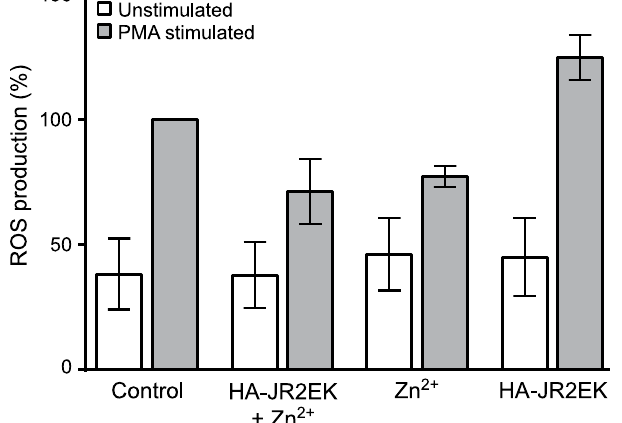
Figure 5. ROS modulatory effects of hydrogels. DCF-DA loaded isolated human neutrophil granulocytes were treated with ± HA-JR2EK (2.5 wt %) ± Zn 2 + (10 mM) prior to PMA (1 µ M) activation. Results are expressed as % ROS production with respect to PMA control ±